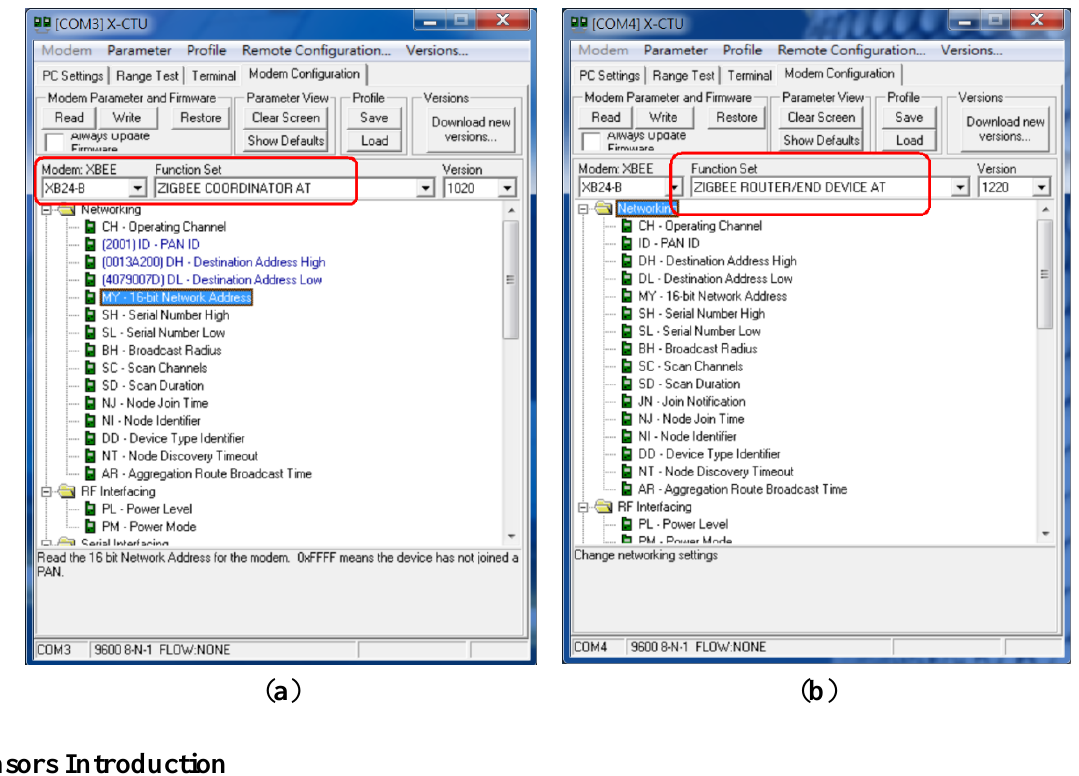
Figure 9. Initializing the ZigBee module network functions. ( a ) Setting a coordinator; ( b ) Setting a router or end